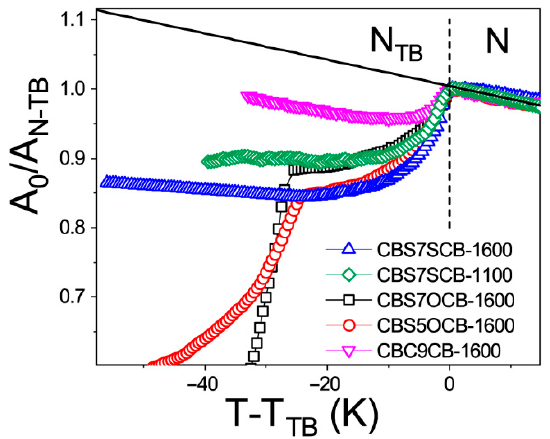
Figure 1. Normalized IR absorbance vs. temperature behavior of the dimers for the longitudinal dipole ( µ ): benzene ring vibration at 1600 cm − 1 ( ν CC) and a deformation vibration of the C-H group in the benzene ring plane at 1100 cm − 1 ( β CH ip CB + ν as C Ar S). (cid:3) –CBSC7OCB, –CBSC5OCB, (cid:52) –CBSC7SCB (1600 cm − 1 ), and (cid:53) –CBC9CB; –CBSC7SCB (1100 cm − 1 ); solid black line—nematic phase trend line. A 0 —integral average absorbance (cm − 1 ), A N-TB —integral absorbance in the transition from nematic to twist–bend phase (cm − 1 ). Table 1. The absorbance changes on transition from the N to the N TB with calculated ratio µ 2 / µ 2 in the presence of weak intermolecular interactions and local orientational order. IMF noIMF Vibration Frequency (cm − 1